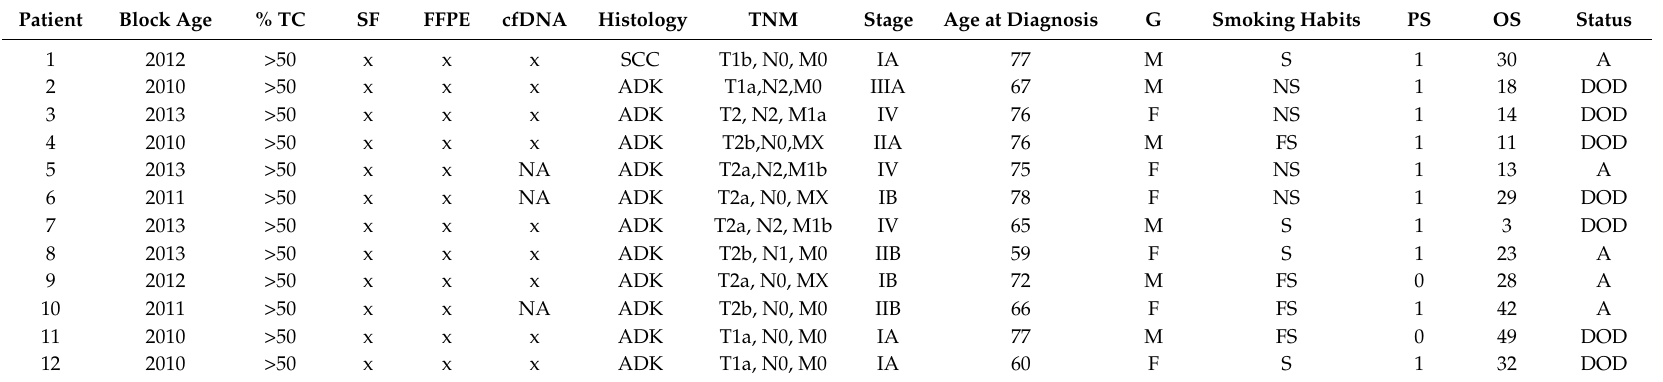
Table 2. Clinical characteristics of NSCLC (Non-small cell lung cancer) in the “Training Set”.